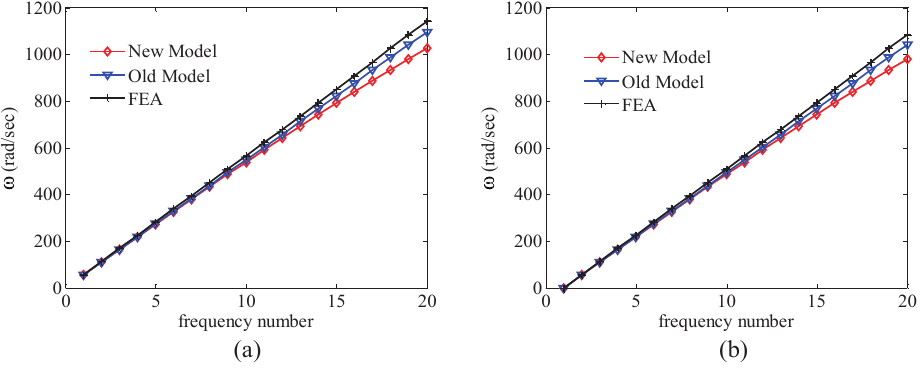
Fig. 5. Longitudinal natural frequencies for a 300 m lattice structure for a) clamped-clamped b) free-free boundary